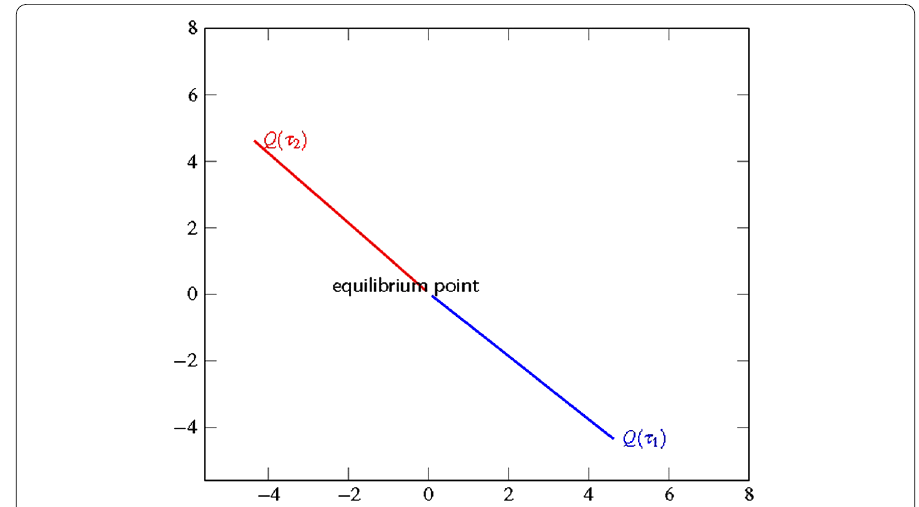
Figure 1 Example 1; The behavior of local fractional entropy for functions Q ( τ 1 ) in the horizontal axis and Q ( τ 2 ) in the vertical axis. Here, we suppose α = 0.95, C ( i ) = 0.499 < 0.5, i = 1,2, and A ( i ) = 0.1, B ( i ) = 0.3. This shows that the entropy solution is a unique solution for the system (6). Moreover, the equilibrium point is at the origin (0,0). Note that when α → 0, the system will loss its equilibrium